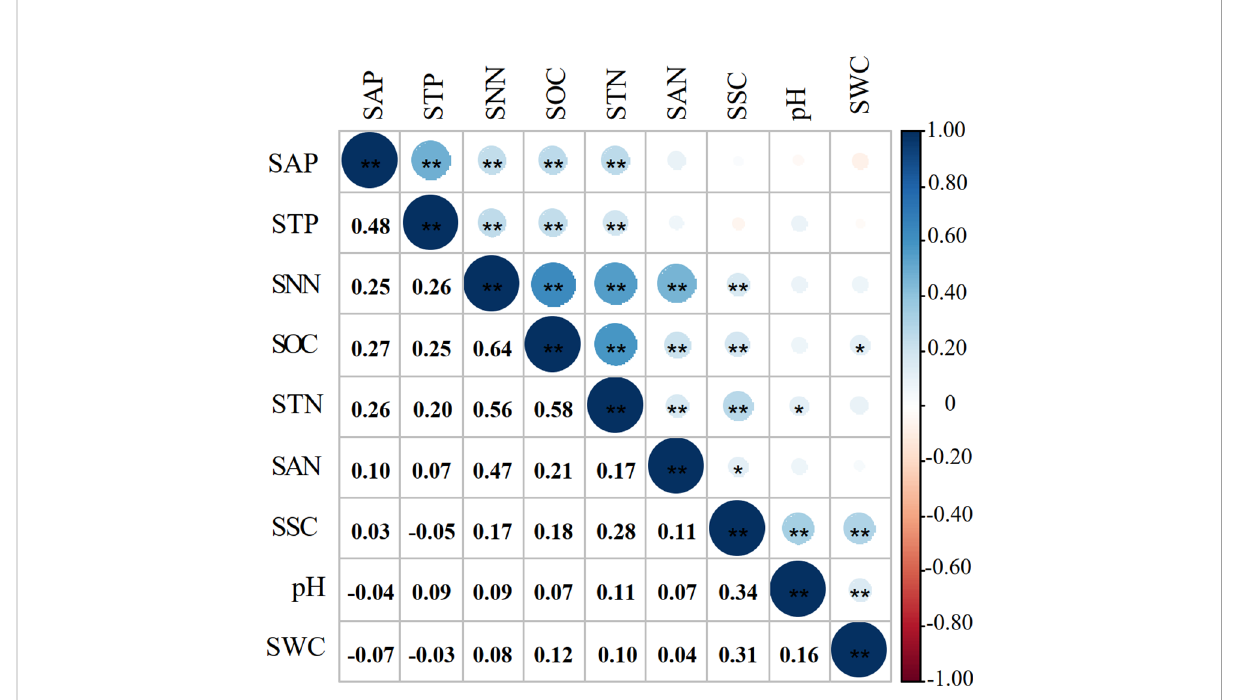
FIGURE 2 Correlation coef fi cients of soil properties. * and ** indicate a signi fi cant correlation at the 0.05 and 0.01, respectively.